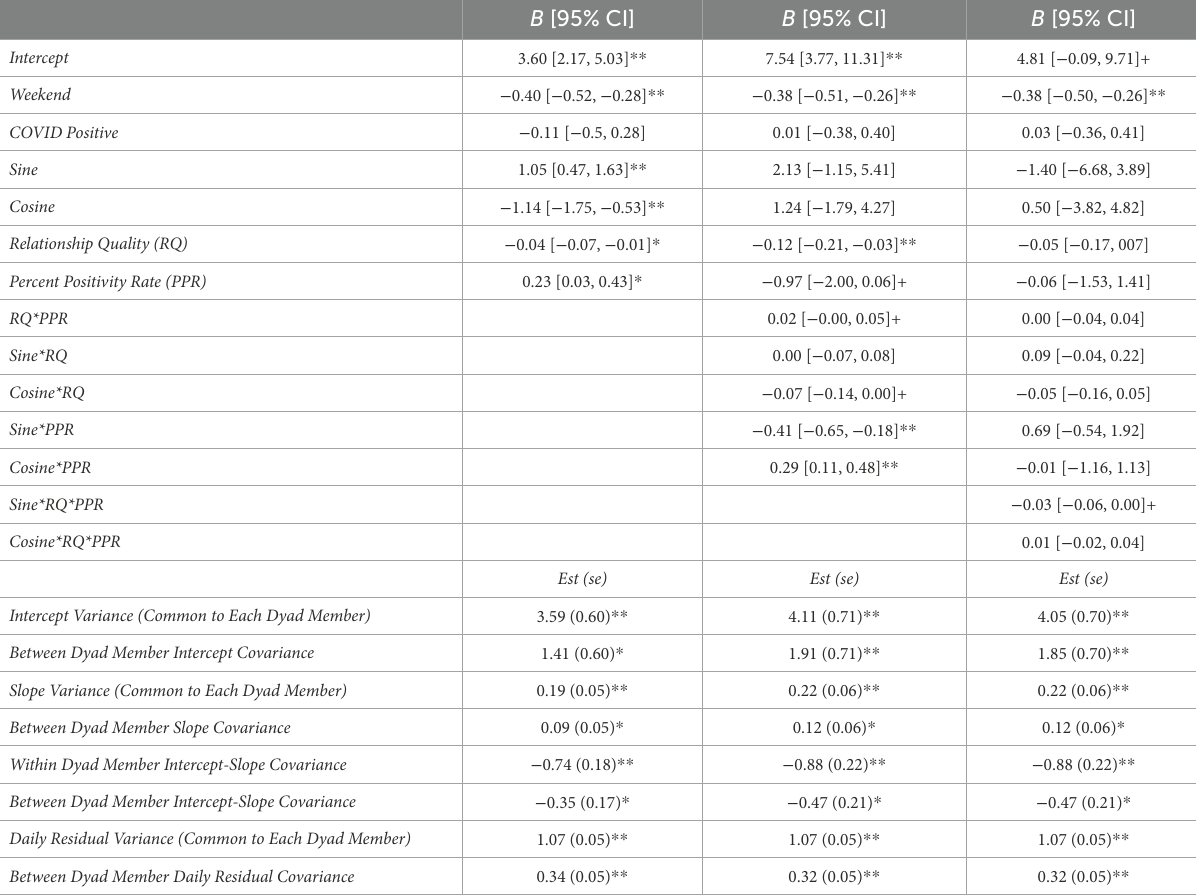
TABLE 1 Estimates for main effects model (column 1), two-way interactions (column 2), and three-way interactions (column 3) predicting daily anxiety.